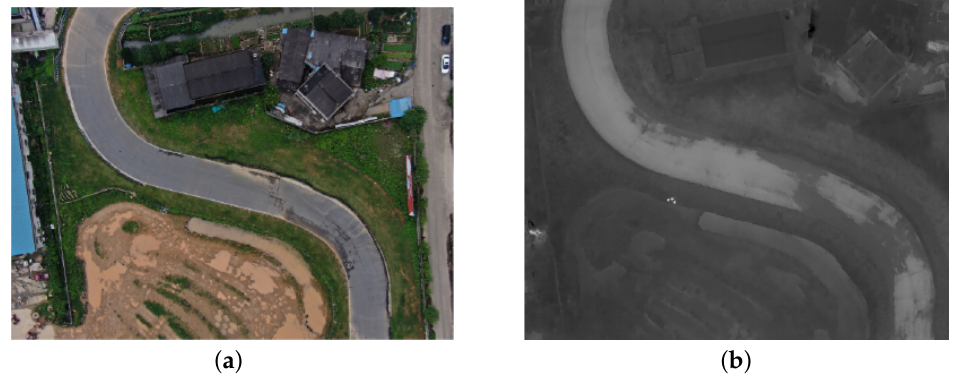
Figure 5. Visible and thermal images are very close in pose and field of view. ( a ) Visible, ( b ) Thermal.